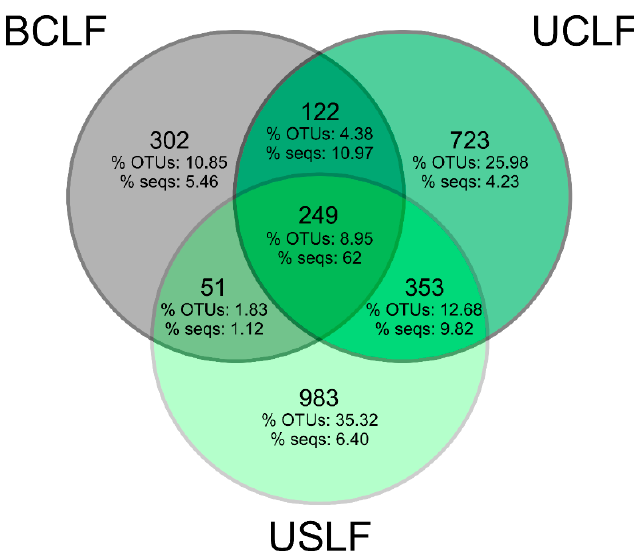
Figure 4. Venn diagram showing the OTU numbers and percentage of sequences in undisturbed laurel forest (USLF and UCLF) and burnt forest (BCLF) soils. The diagram also shows OTUs and percentages of sequences in the core